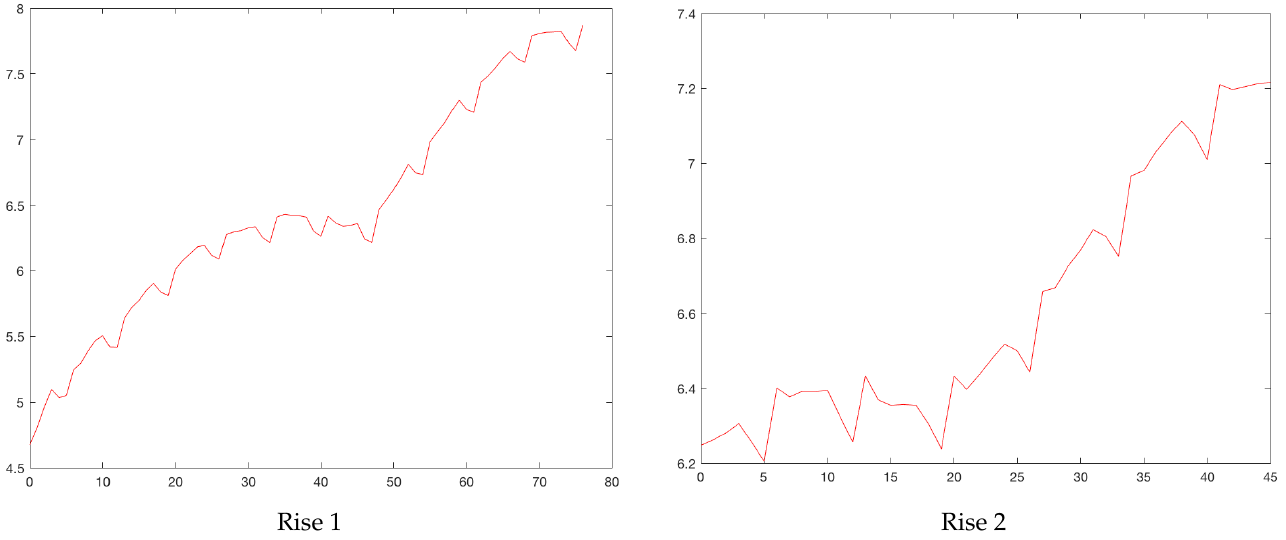
Rise 1 Rise 2 Figure A10. Lyon’s rises. Horizontal axis, days; vertical axis: logarithm of daily